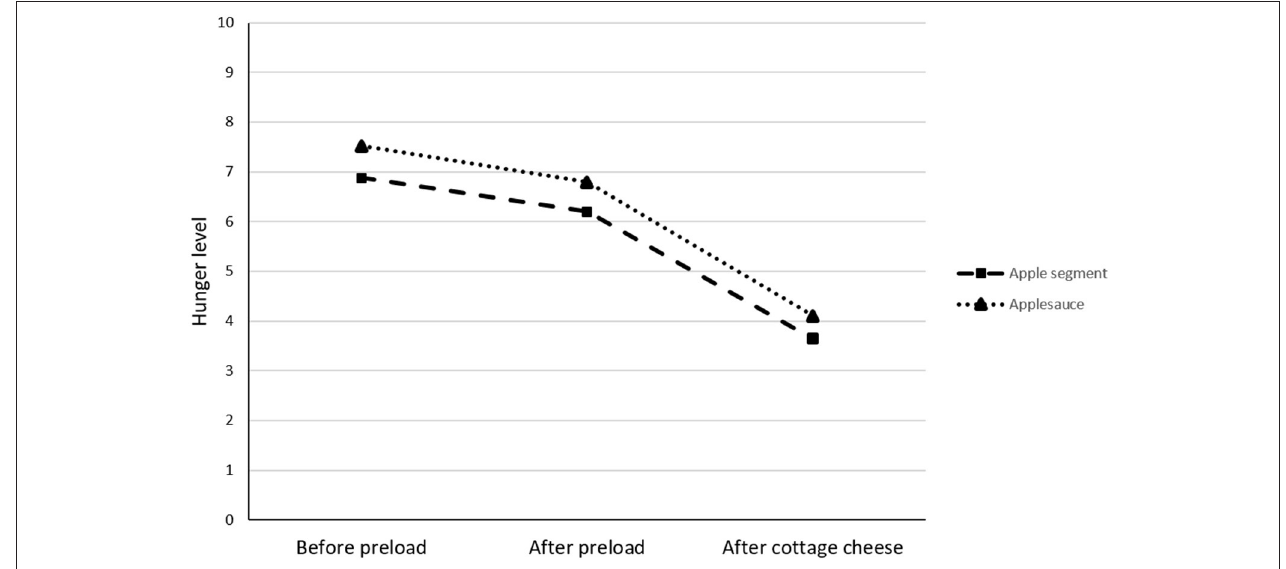
FIGURE 2 | Hunger ratings (mean ± SD) for the 44 children before and after preload and after cottage cheese consumption. The hunger level significantly decreased over the course of the mid-afternoon snack regardless of the preload type consumed (time, F (2, 215) = 115.47, p < 0.0001; preload type, F (1, 215) = 9.07, p = 0.0029), but the time × preload type interaction was not significant ( p =